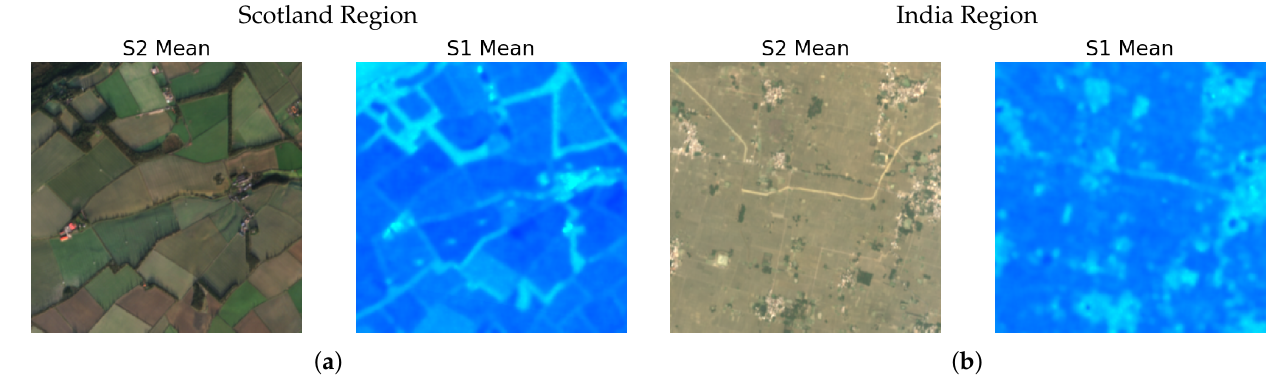
Figure 3. Mean images for year 2019 for the region in Scotland ( a ) and the region in India ( b ). Sentinel-1 VV and VH are displayed as green and blue,